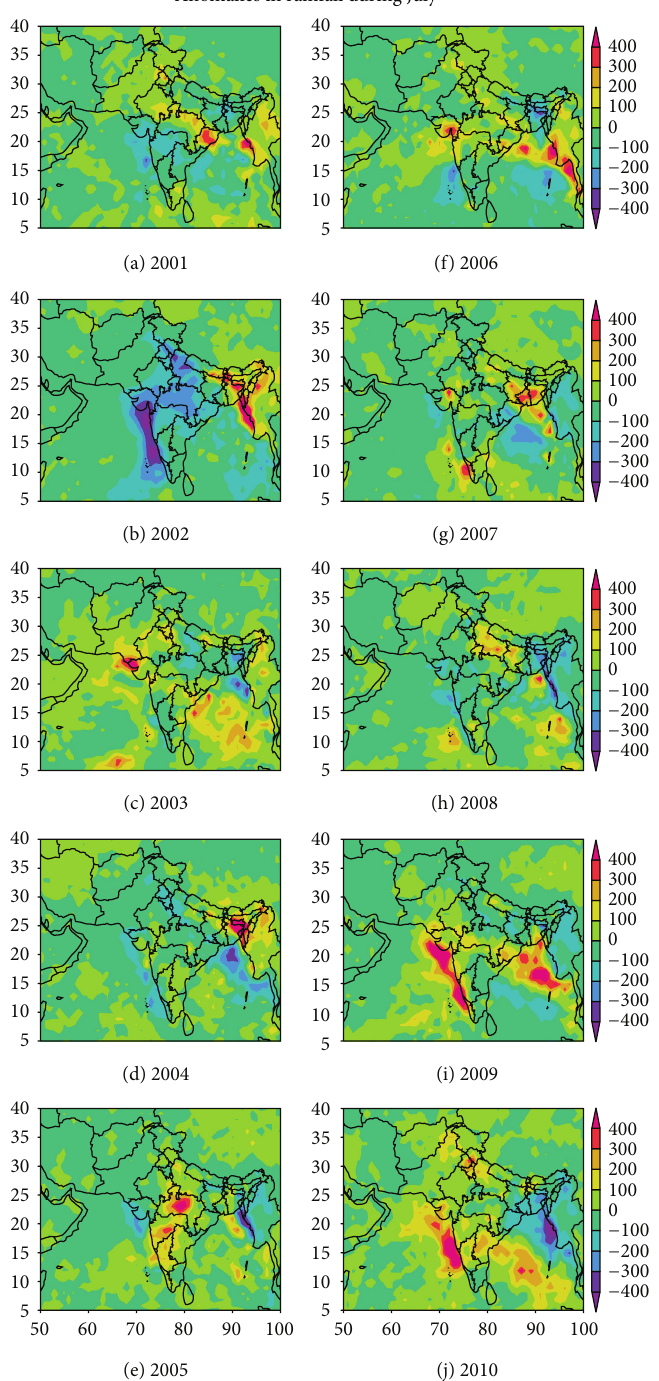
Figure 9: Anomalies in rainfall (mm) over the Arabian Sea, India, and the Bay of Bengal during July in (a) 2001, (b) 2002, (c) 2003, (d) 2004, (e) 2005, (f) 2006, (g) 2007, (h) 2008, (i) 2009, and (j) 2010.